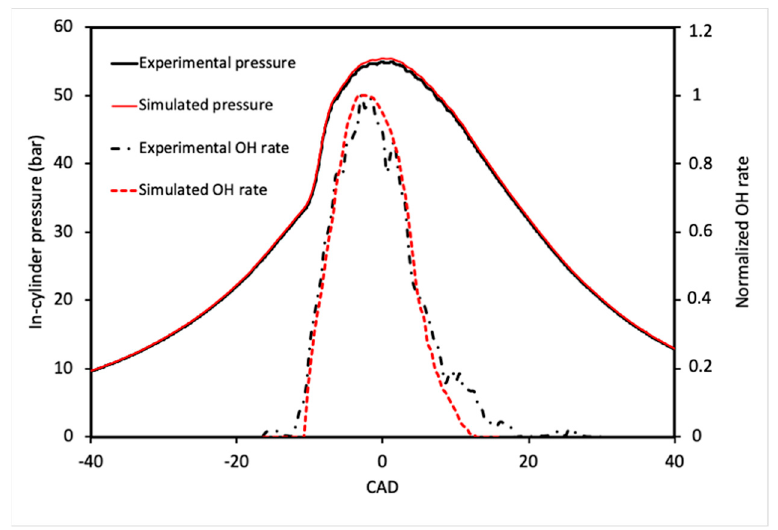
Figure 9. Experimental and numerical OH rates and in-cylinder pressure profiles comparison when the injection pressure is equal to 700 bar and engine speed fixed at 1500 rpm.